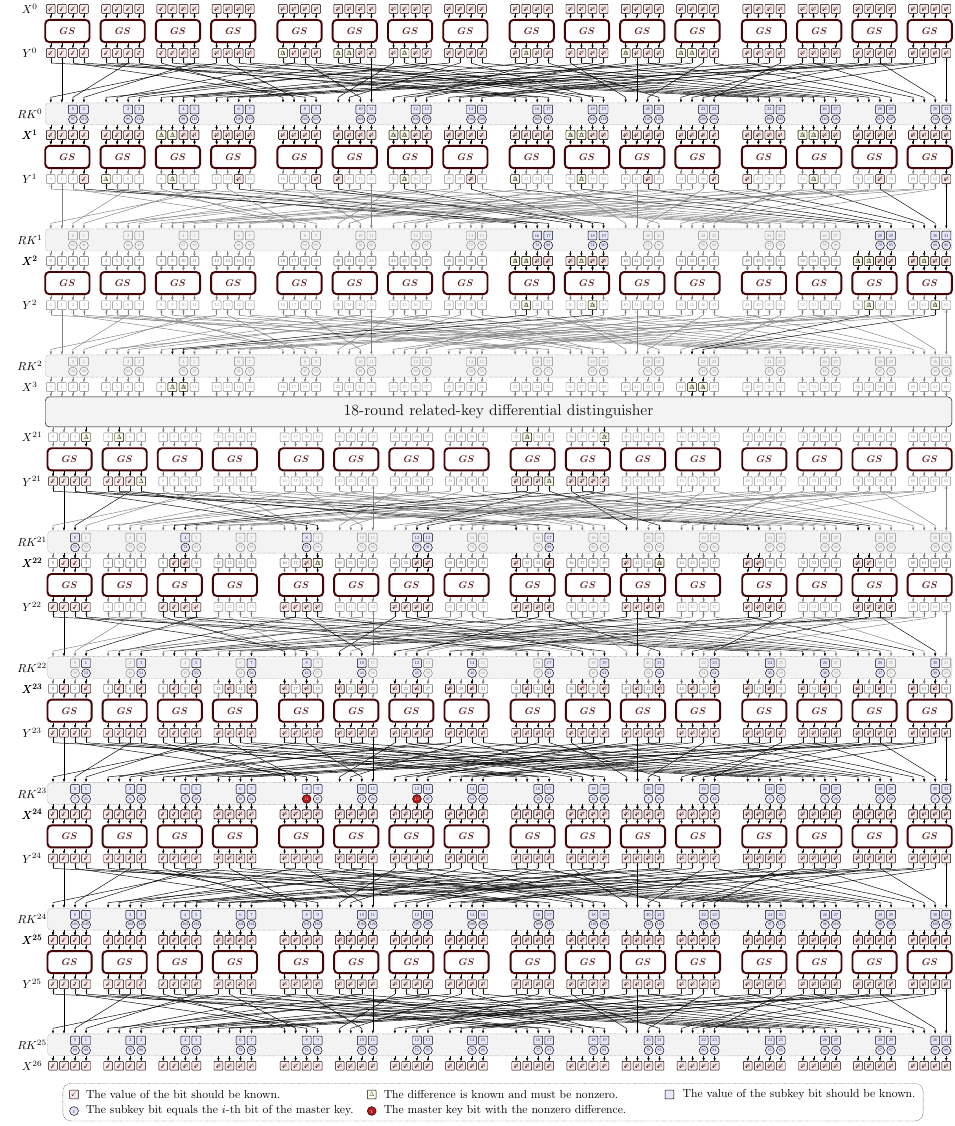
Figure 9: Key-recovery attack on 26-round GIFT-64